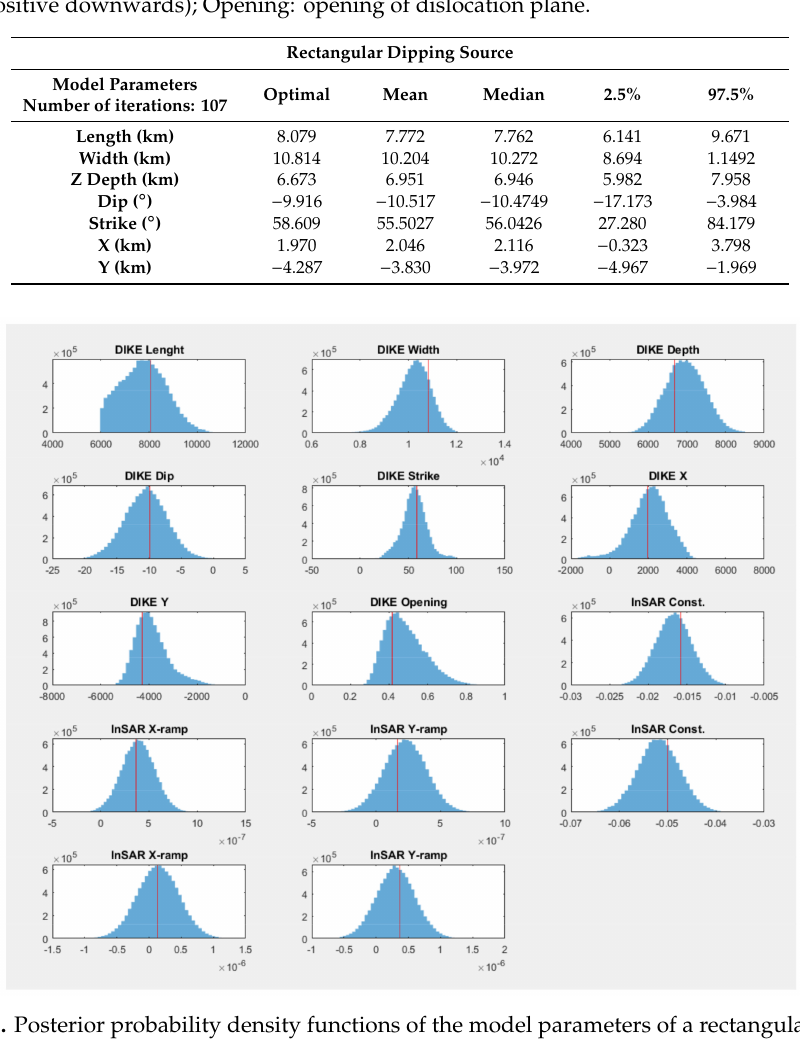
Figure A1. Posterior probability density functions of the model parameters of a rectangular dipping source. The red line indicates the maximum a posteriori probability solution. See the description of Table 2. for parameters details.